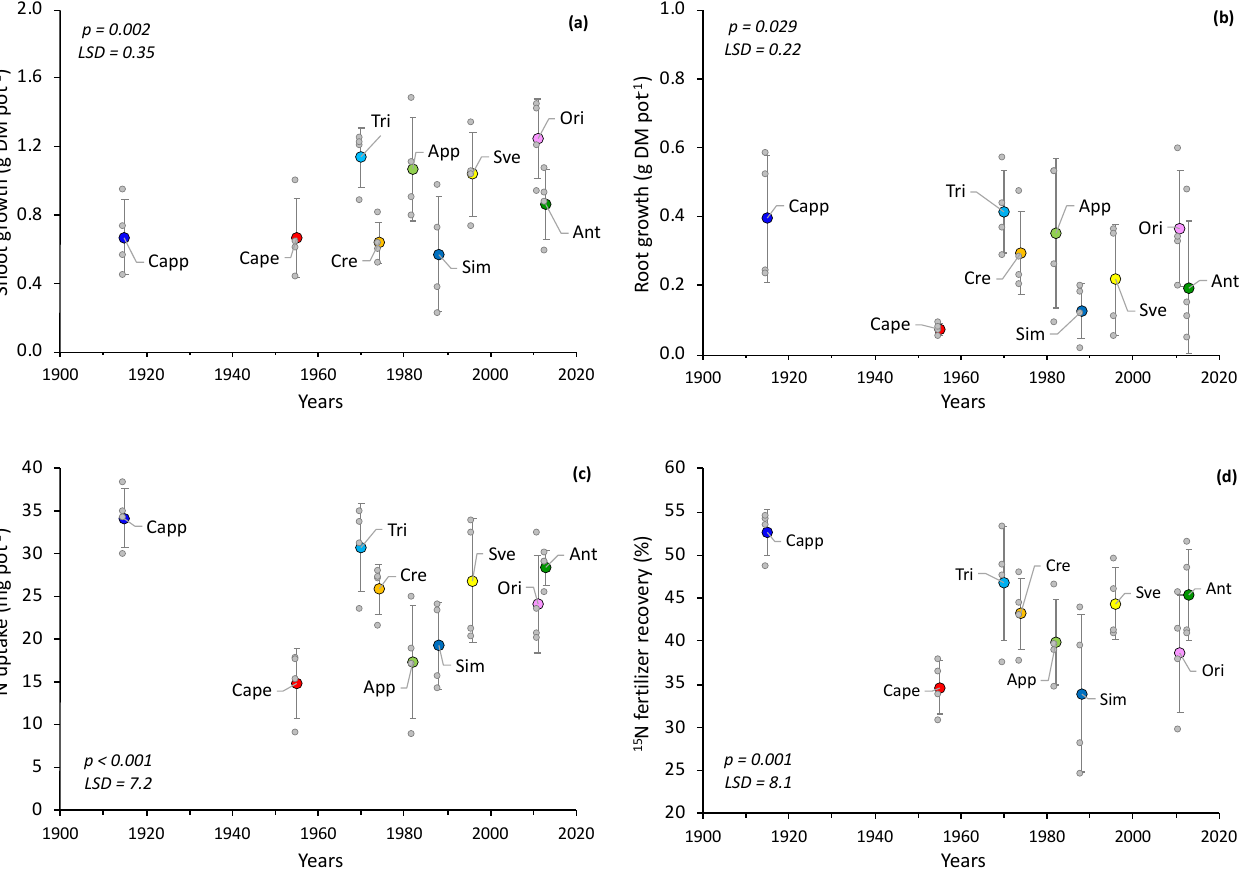
Figure 1. Relationships between shoot N uptake ( a ) and root N uptake ( b ) and the year of release of the nine studied genotypes at 90 days after emergence (Time 1). For each trait the p value and the LSD (Fisher’s LSD test, p = 0.05) are reported. All genotype data are plotted with the mean depicted as a colored circle ± standard deviation ( n = 4) represented by the end of the vertical black line. N, nitrogen; LSD, least significant difference.